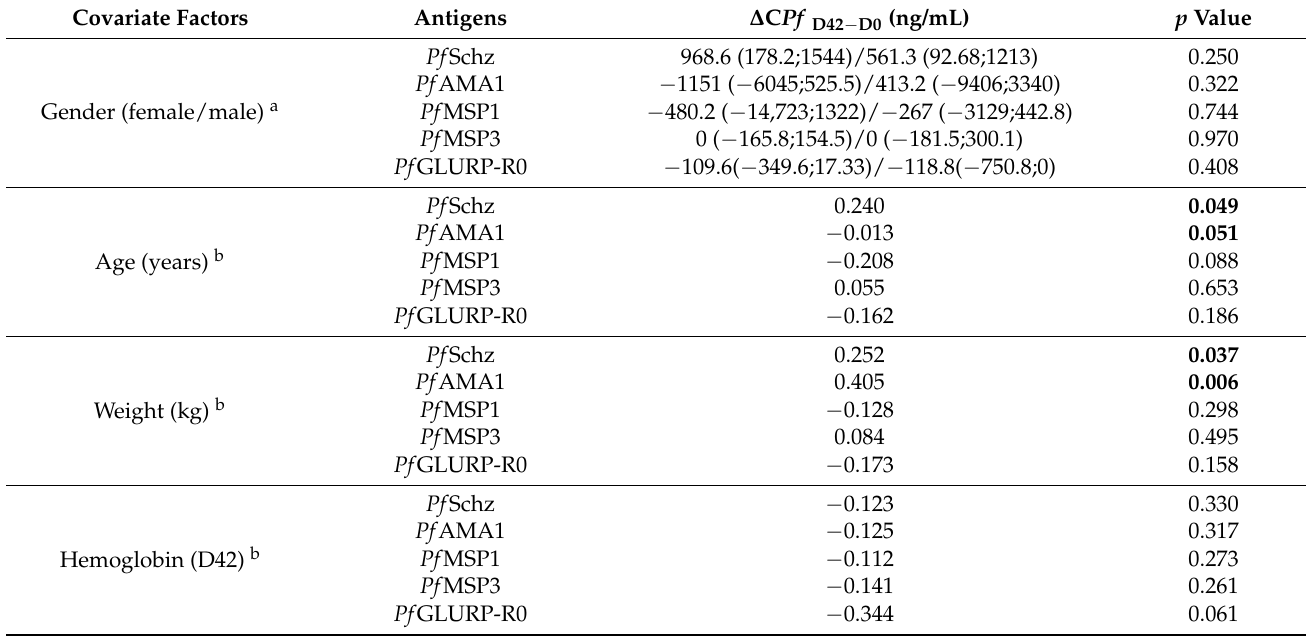
Figure 2. Variation in concentration of IgG response to P. falciparum antigens according to group of exposure to Anopheles and to Aedes (combined exposure). Each dot represents an individual, and box plots indicate the median value, 25th and 75th percentile antibody concentration for each blood-stage antigen. Individuals were divided into three groups (E2, E3, E4) where E2 includes individuals with lower exposure to both Anopheles and Aedes, E4 includes individuals with higher exposure to both Anopheles and Aedes , and E3 includes individuals with weak exposure to one mosquito genus and high exposure to the other. Statistically significant difference in median value between two groups is indicated (Mann–Whitney U test). Table 2. Influence of covariates on the dynamics of IgG antibody levels to various Plasmodium and mosquito salivary